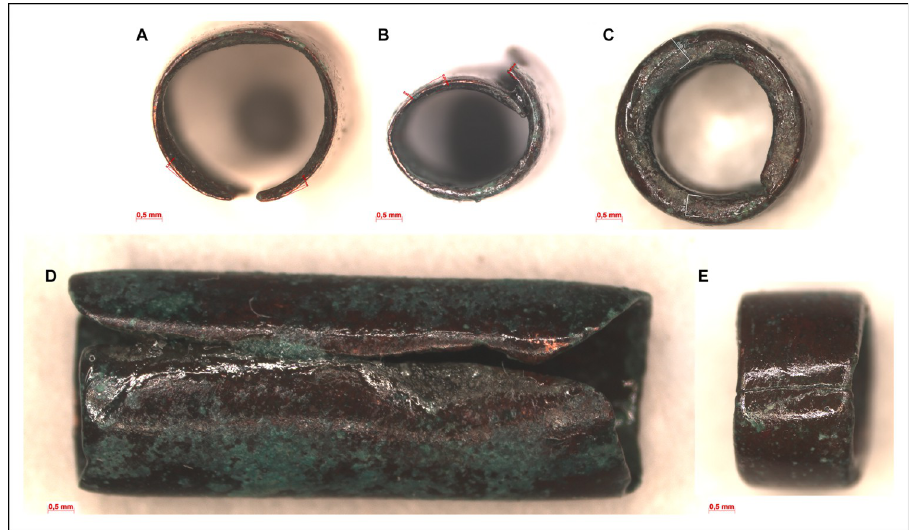
Fig 11. Micrographs showing the macrostructure of cylindrical beads. Photo: Eszter Horva´th. (A–C) Plan view of some selected copper beads showing differences in their wall-thickness and quality of the joints (O˝.2019.8.1.283.). (D– E) Side view of some selected copper beads showing differences in their length and quality of the